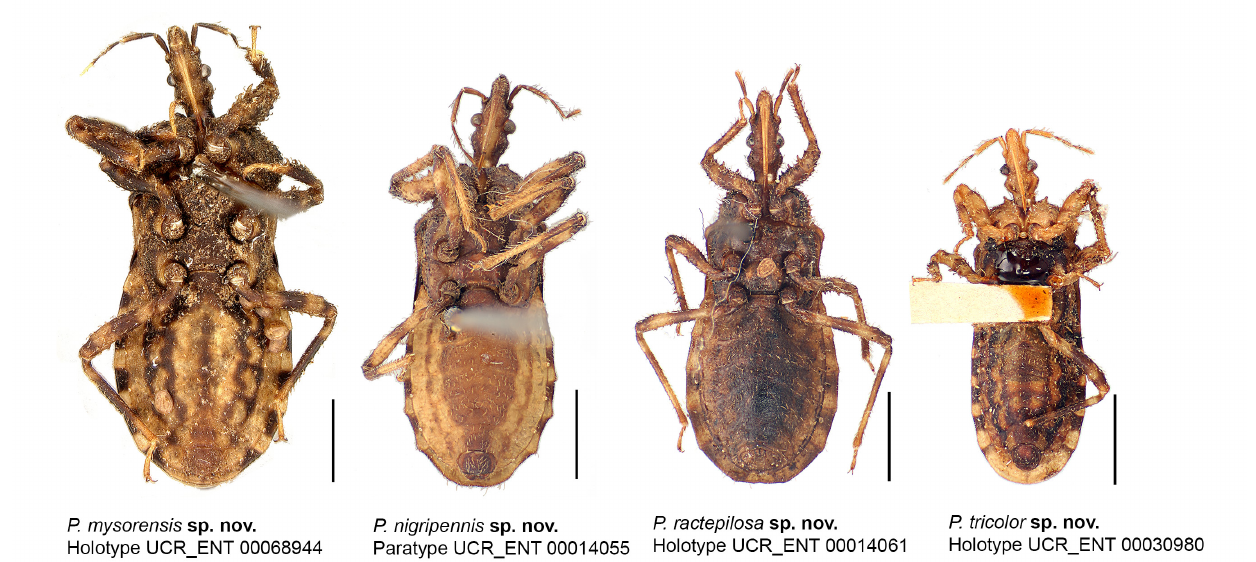
Fig. 18. Ventral habitus images for species of Physoderes Westwood, 1845 (partial). Scale bars = 2